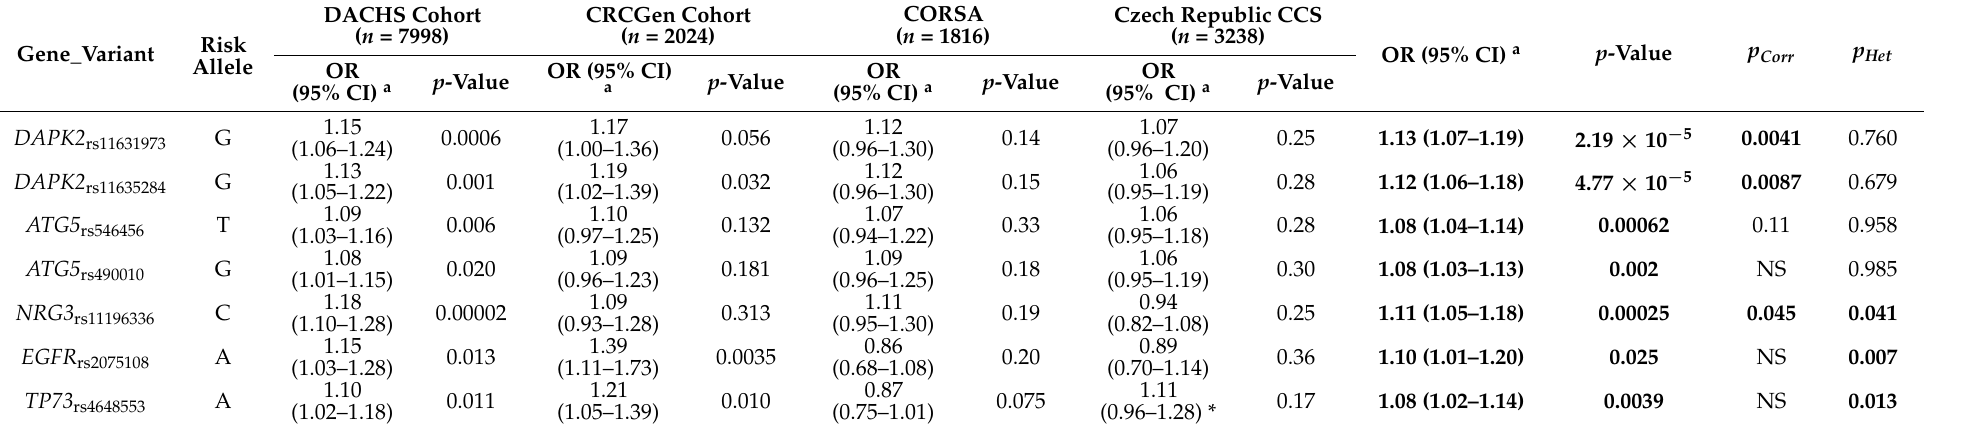
Table 2. Association estimates of the most interesting autophagy-related variants and CRC risk in the four study